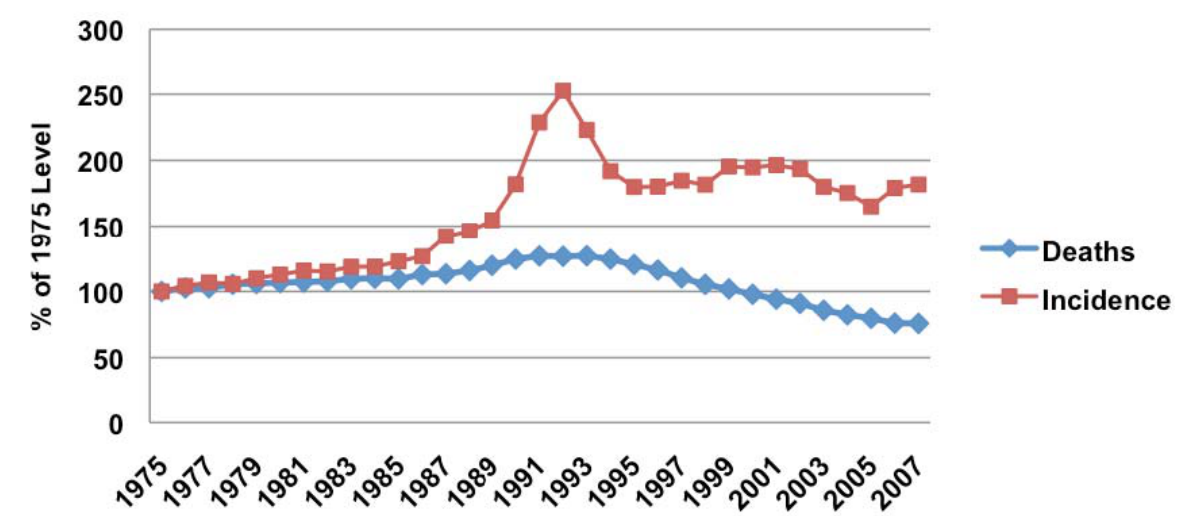
Figure 1. Relative changes in incidence and prostate cancer deaths in the United States from 1975 to 2007. Data from